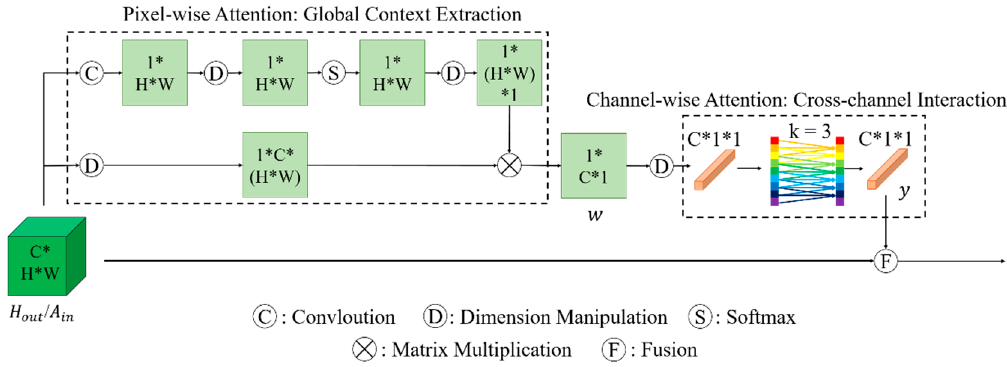
Figure 7. Double Attention Module.